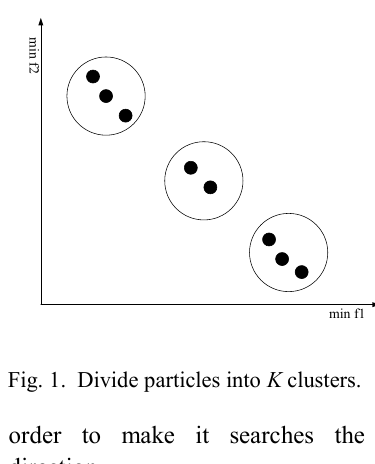
Fig. 1. Divide particles into K